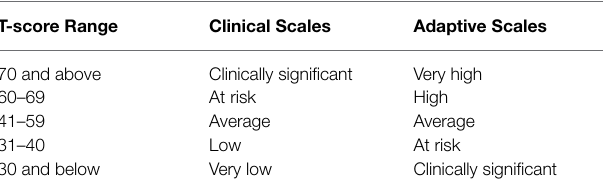
TABLE 4 | Basc-3 scale and composite score classification (Reynolds and Kamphaus,